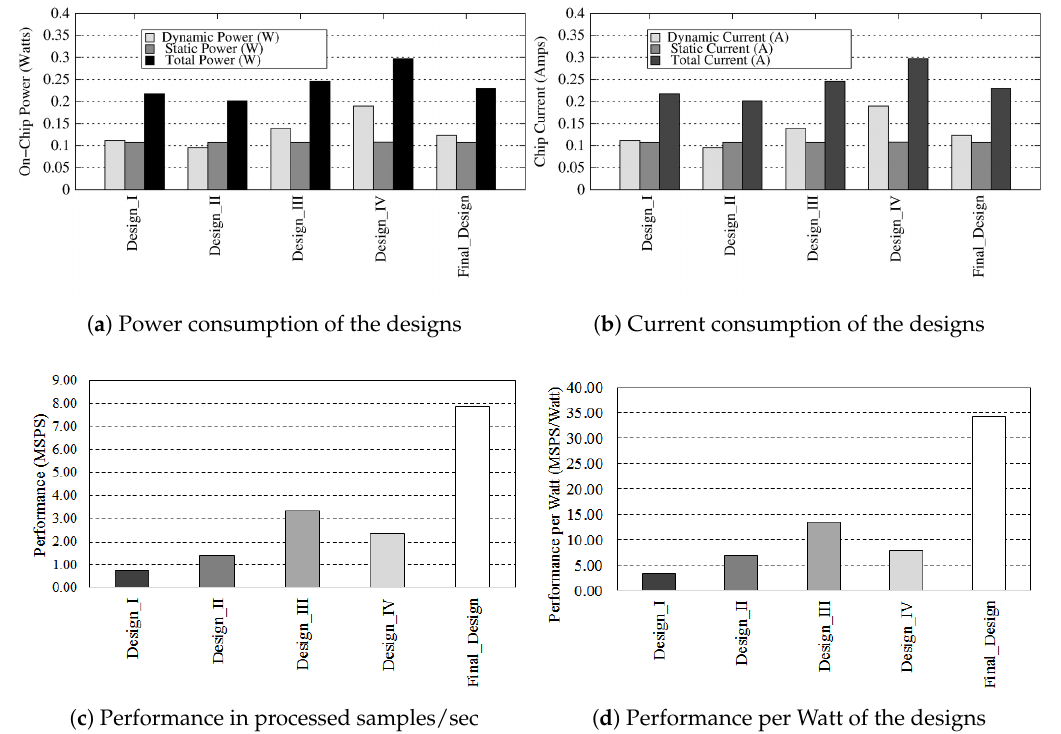
Figure 9. Power and performance results of hardware